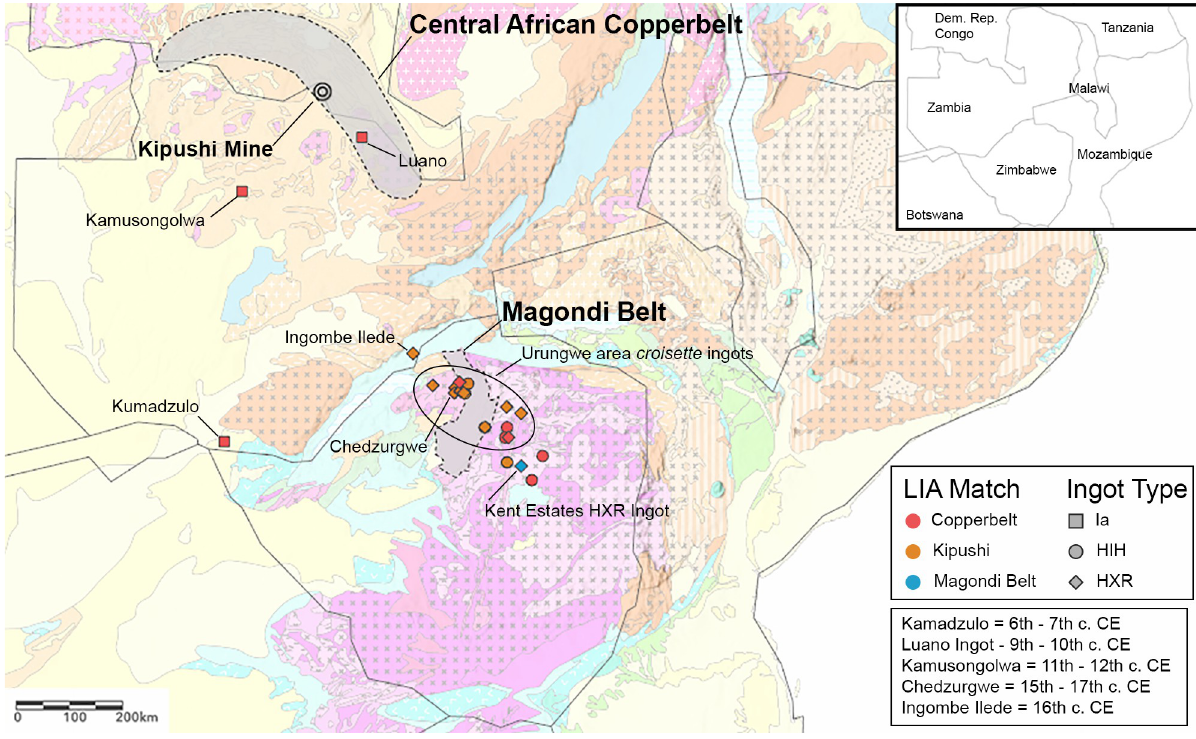
Fig 11. Map of the inferred provenance conclusion for each rectangular, fishtail, and croisette ingot in this study. Provenance results indicate that objects travelled significant distances to reach certain destinations and that interactions between the Copperbelt and areas further south can be traced back to the 6 th -7 th century CE. Geological basemap adapted from Thie´blemont et al. [20].